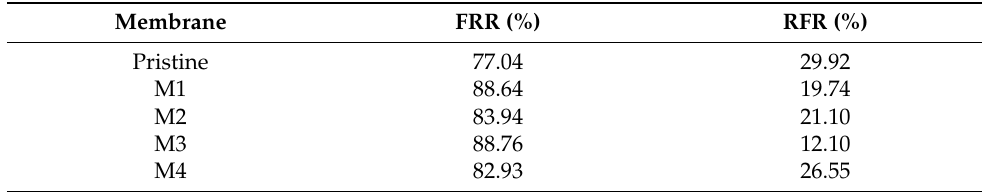
Table 8. Antifouling properties of the membrane samples.